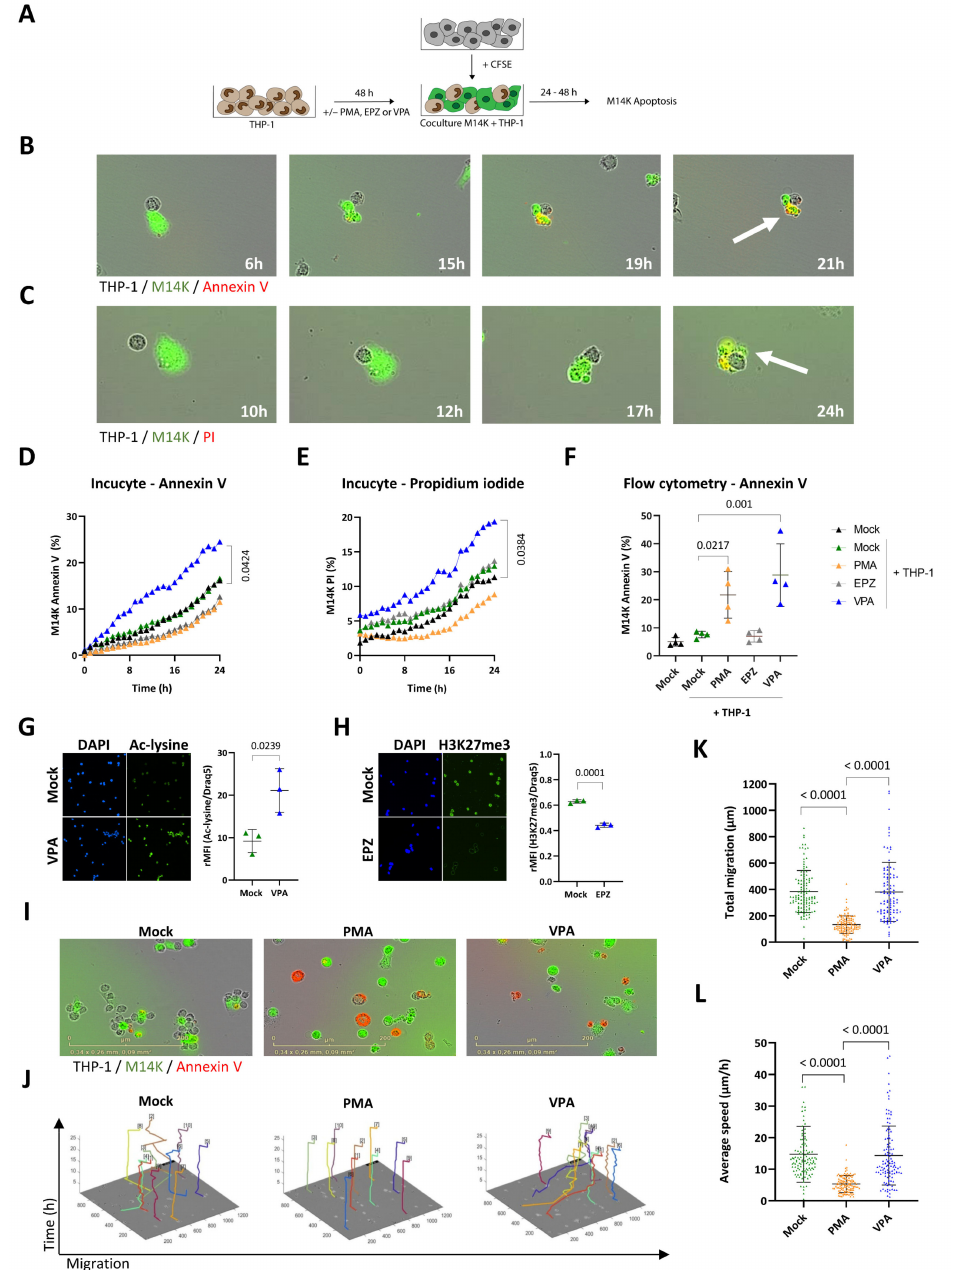
Figure 1. Direct cytotoxicity of THP-1 monocytes in contact with mesothelioma M14K cells. ( A ) Experimental design. THP-1 monocytes were treated with 16.2 µ M of PMA, 2.5 mM of VPA, or 10 µ M of EPZ005687 (EPZ) for 48 h. After washing the medium, THP-1 monocytes were